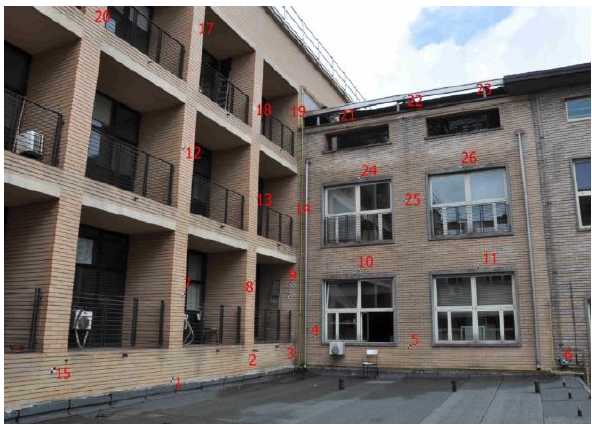
Figure 1. Calibration field for lens and sensors distortions The software Leica Photogrammetric Suite (LPS) suite of ERDAS has been used for the self-calibration of the device. The procedure requires to insert at least two images, which have unknown internal orientation parameters, and collimate the